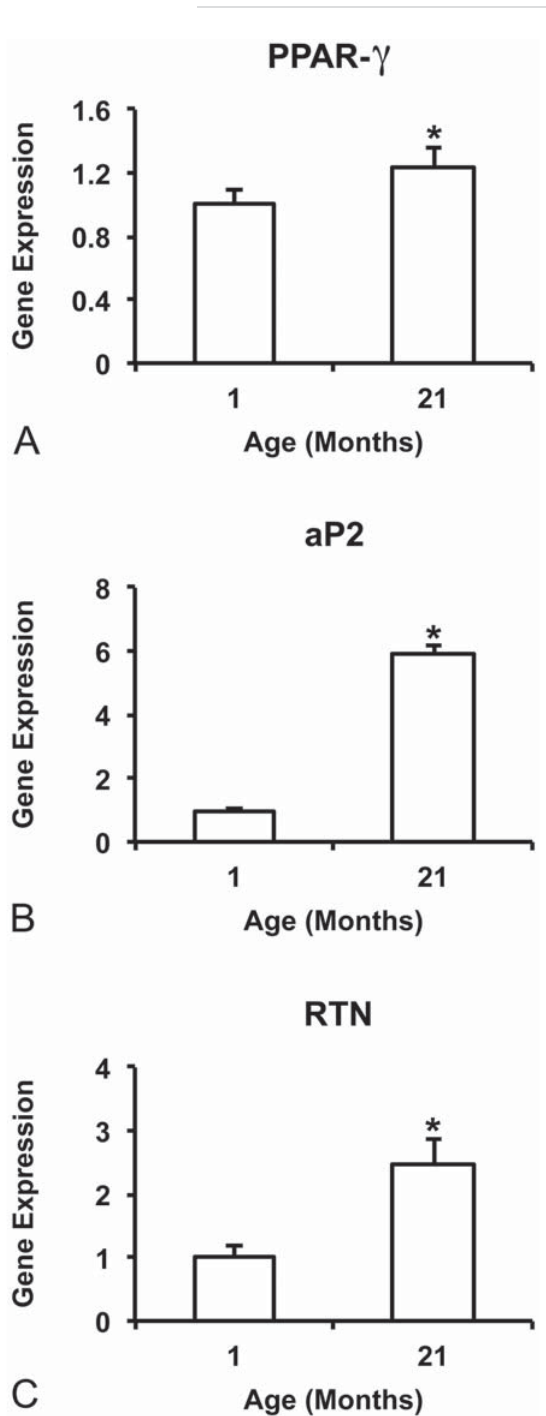
1-month rats. Lipid accumulation Lipid accumulation was detected on Ti discs irrespective of cell source, with cells from 21-month rats producing the most dense lipid droplets (Figure 3). Additionally, the lipid content was nearly twice higher (p=0.010) in cultures from 21-month rats compared with 1-month rats (Figure 4).